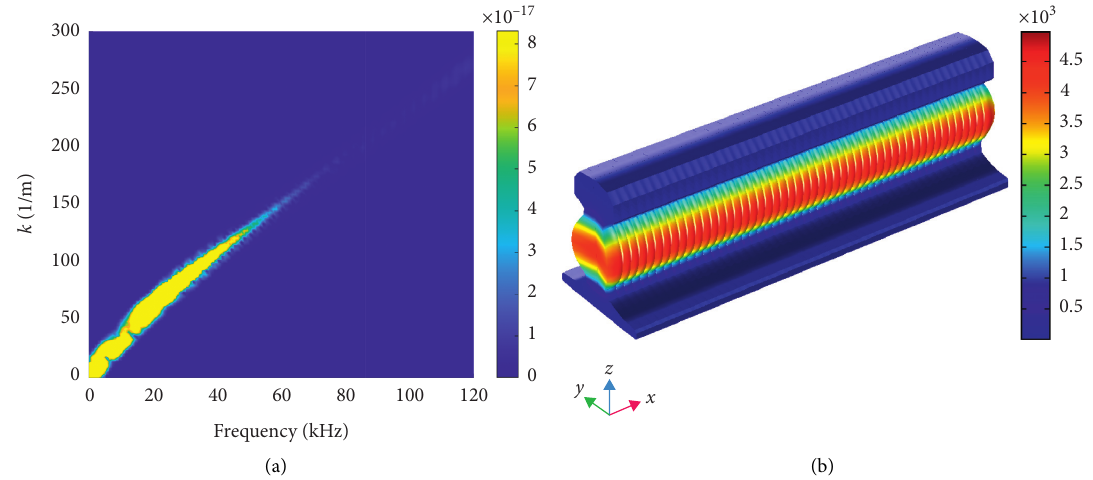
Figure 8: UGW mode W0 identification: (a) filtered spectrum and (b) 3D mode shape of W0 at 60kHz.